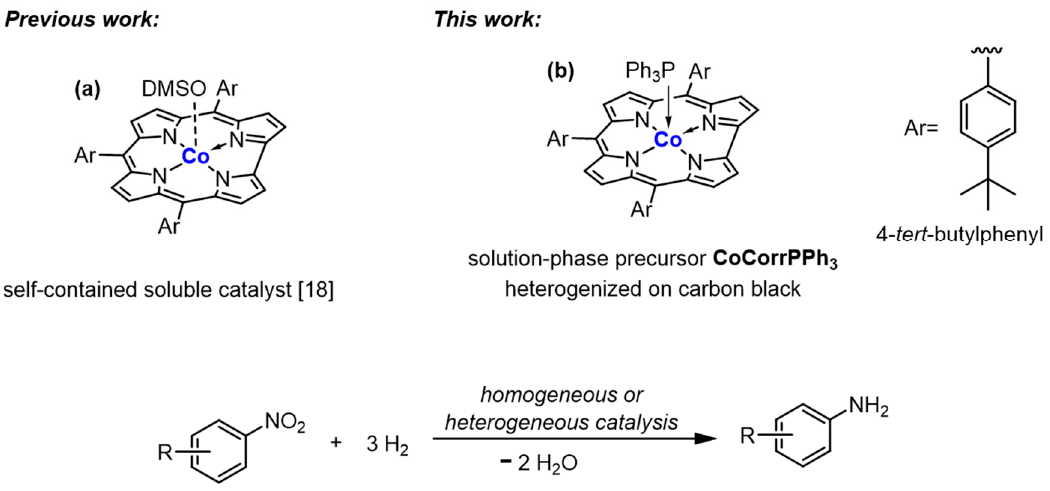
Figure 2. ( a ) A molecularly well-defined cobalt-corrole complex was shown to bring about the homogeneous hydrogenation of nitroarenes to afford a variety of aniline derivatives [18]. ( b ) Herein, a pre-fabricated phosphine-tagged cobalt corrole, which can be considered as a curtailed vitamin B 12 analog, was merged with carbon black (Vulcan ® XC 72 R) and then pyrolytically activated to catalyze the same nitroarene-to-aniline hydrogenation.